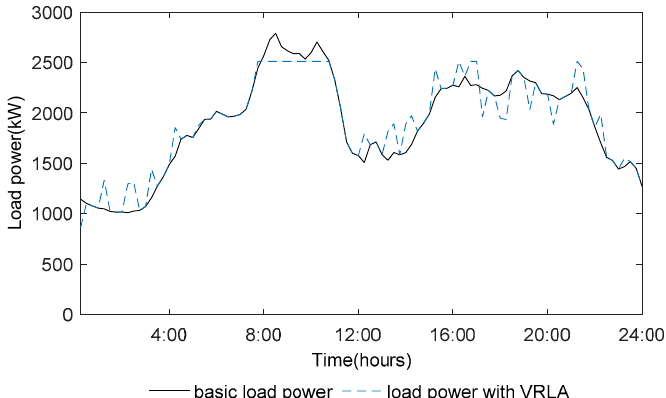
Figure 9. User load power with VRLA (Demand response).